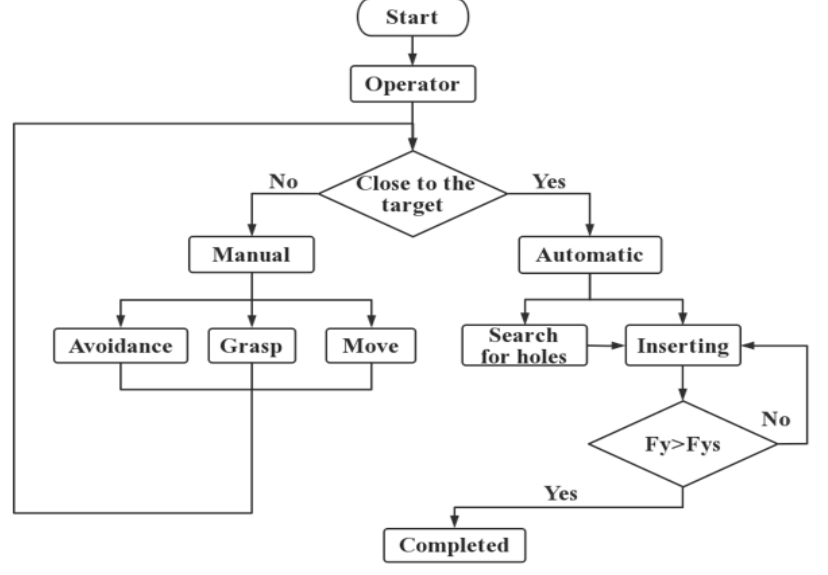
Figure 3. The strategy of manual/automatic mixed control.